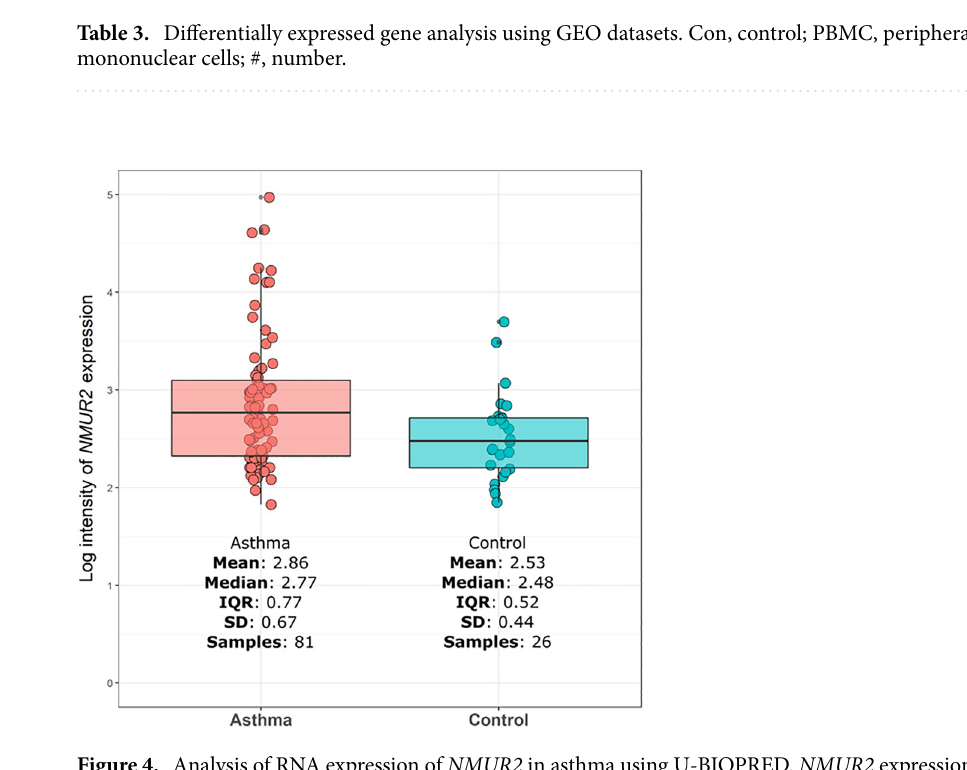
Figure 4. Analysis of RNA expression of NMUR2 in asthma using U-BIOPRED. NMUR2 expression was measured in the bronchial tissue of 81 asthma samples and 26 controls. Box plot shows log intensity of the NMUR2 in asthma and controls.